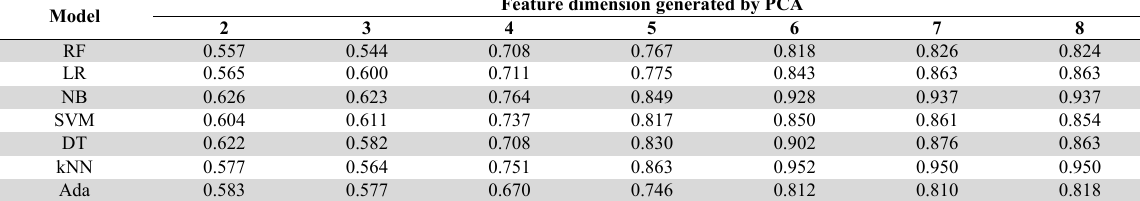
Figs. (10-14) show the relationship between evaluation measure and feature space dimension for each machine learning model. The findings in these figures suggest that all models behave similarly with a bad performance at small feature space dimensions and these results getting improved while the dimension is